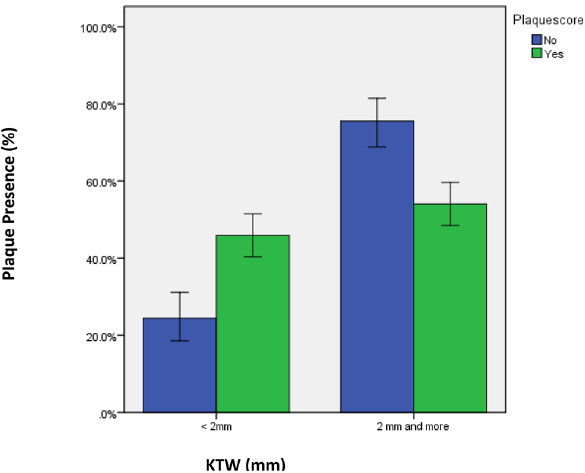
Figure 2. Percentage of plaque presence (yes vs. no) based on keratinized tissue width (KTW) around